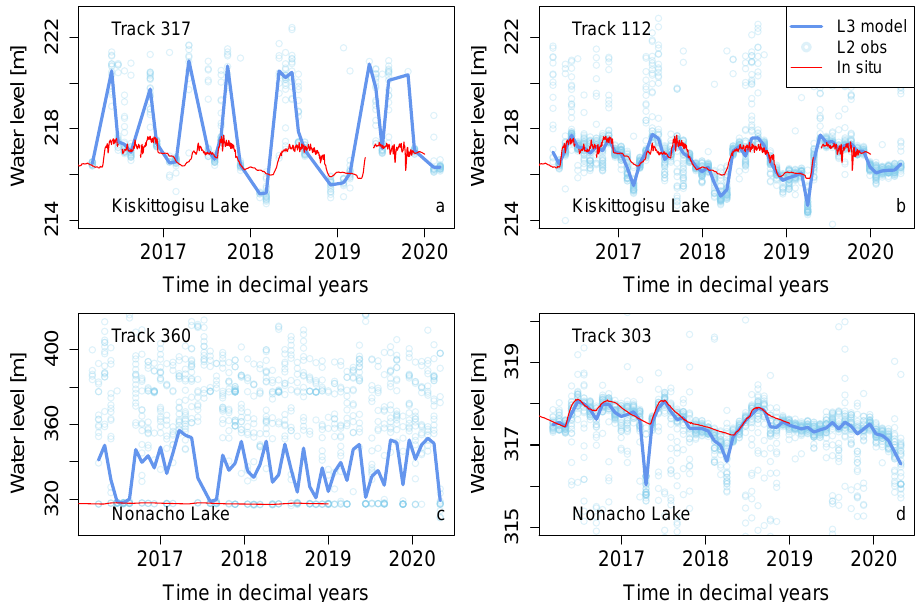
Figure 6. Examples of two lakes, where the time series model fails to reconstruct the observed water level due to noisy data. Subplots ( a , b ) show lake level time series for lake Kiskittogisu based on track number 317 and 112, respectively. Subplots ( c , d ) show lake level time series for lake Nonacho based on track number 360 and 303,